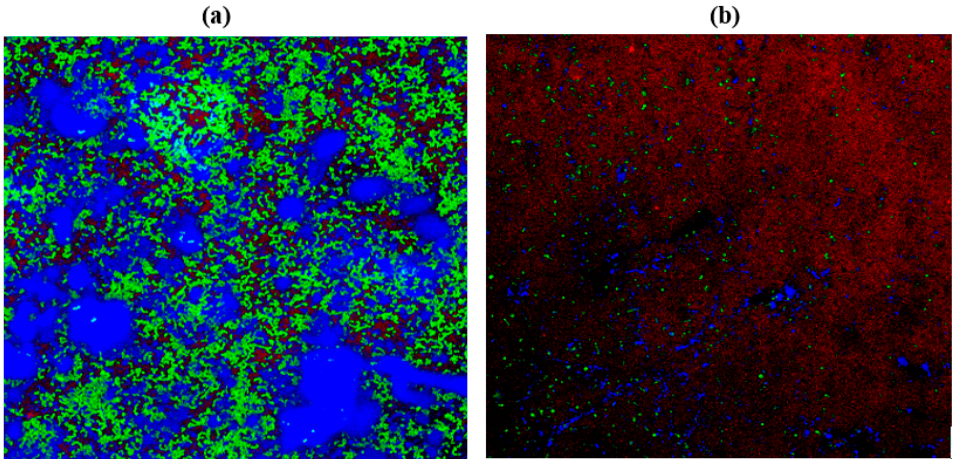
Figure 10. 3D resolution images of C. albicans M207+ E. coli ATCC 39936 control using CLSM at ( a )